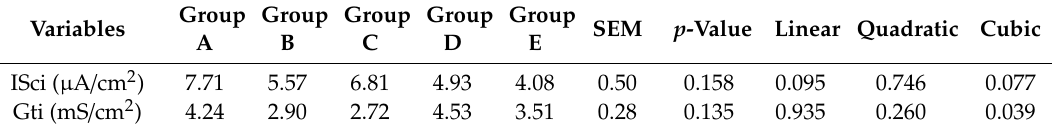
Table 3. Effect of Cr-CNPs supplementation on initial short-circuit current and tissue conductance before the addition of glucose.